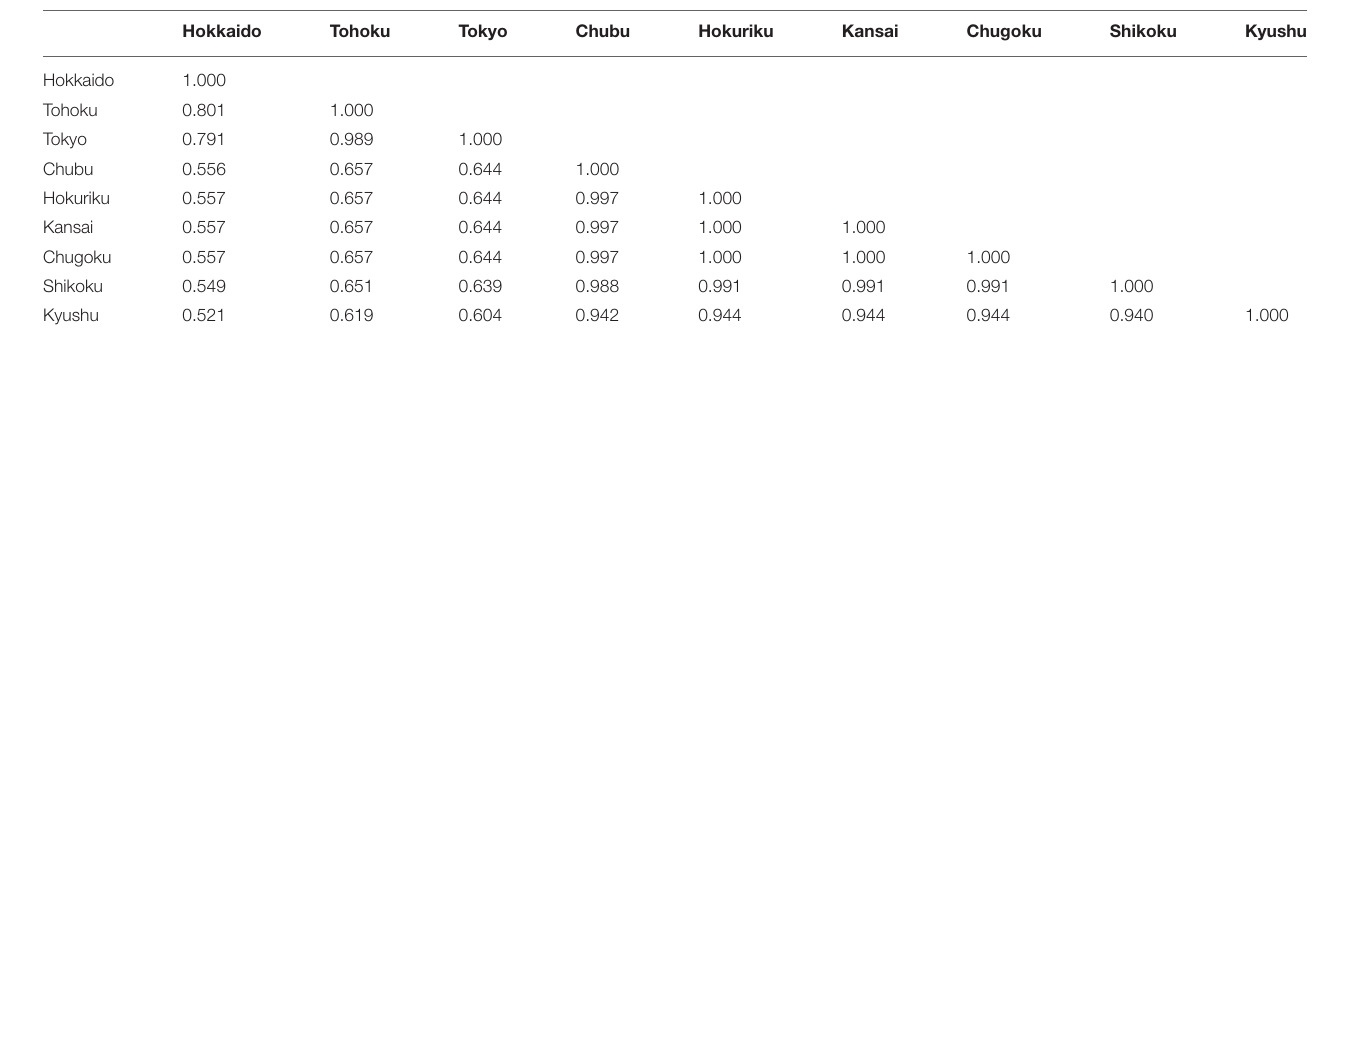
TABLE A1 | Results of correlation analysis for each area